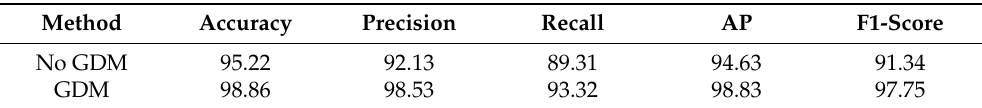
Table 7. Contribution of the GDM to final benefit. The analysis results show that F = 10.623 > F crit = 5.317, P = 0.012 < α = 0.05, reject H 0